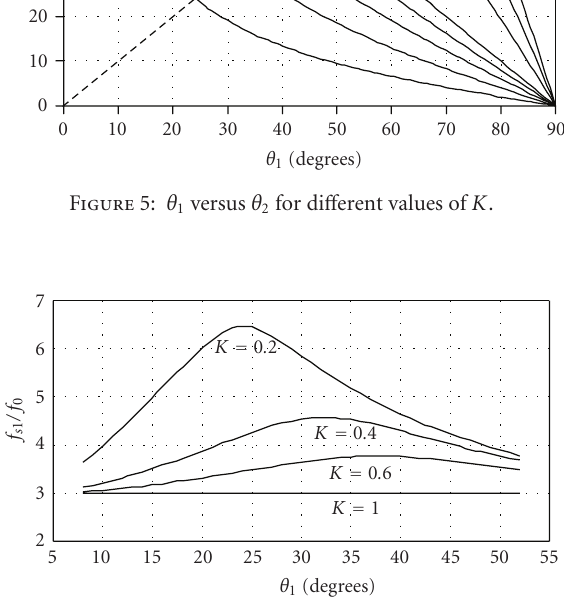
Figure 6: Variation of the first spurious frequency with the impedance ratio K